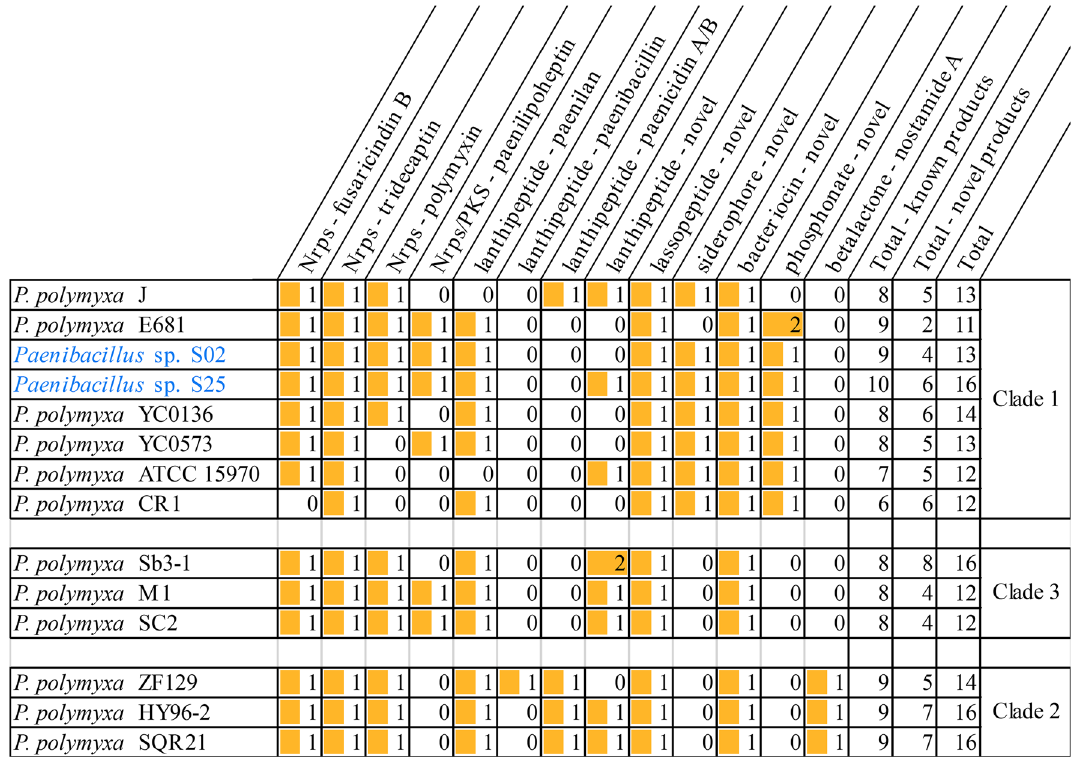
Table 1. Secondary metabolite gene clusters identified in Paenibacillus sp. strains S02 and S25 and 13 P. polymyxa strains with complete circular genome sequences. The type and product of each secondary metabolite gene cluster were shown in the first row. Numbers are the total count of each secondary metabolite gene cluster. The length of the orange bar represents the total count of each secondary metabolite gene cluster. Novel: Similarity ≤ 70% when compared to the most similar known cluster in the antiSMASH database. Nrps: Nonribosomal peptide synthetase. PKS: Polyketide synthase. Clade 1/2/3: Clades identified in phylogeny and comparative genomics study (“Phylogeny and comparative genomics”